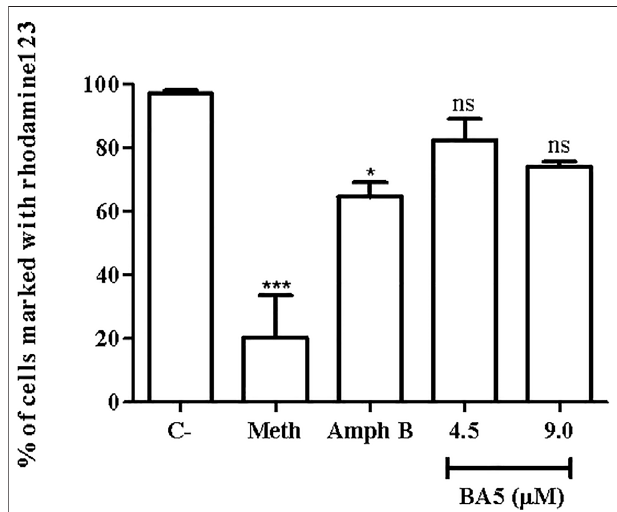
FIGURE 5 | Mitochondrial membrane potential of L. amazonensis promastigotesincubatedwithBA5.Promastigoteswereincubatedornotwith BA5atconcentrationsofIC 50 and2xIC 50 andamphotericinB(IC 50 ).Methanol (Meth) was used as positive control. After 72 h of incubation, parasites were marked with rhodamine123. The samples were acquired in a LSRFortessa fl owcytometerandanalyzedbyFlowJosoftware(50,000events were collected and analyzed). *** p < 0.001, compared to untreated